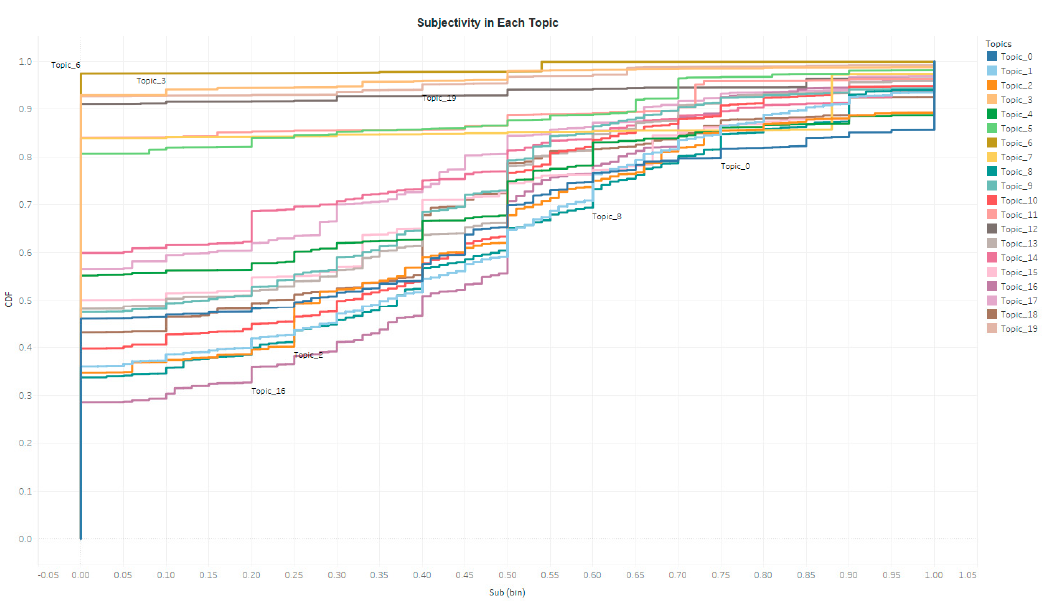
Figure 4. Subjectivity in each topic.